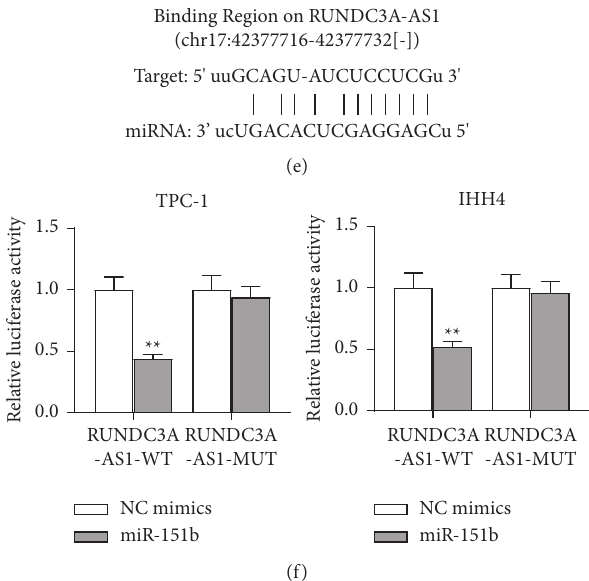
Figure 3: RUNDC3A-AS1 binds to miR-151b. (a) ENCORI showed two miRNAs that have binding sites with RUNDC3A-AS1 (CLIP data ≥ 1, Pan-cancer ≥ 10). (b) ENCORI showed the low expression of miR-151b in THCA. (c) The relative expression level of miR-151b in THCA cell lines was examined by RT-qPCR. (d) Overexpression efficiency of miR-151b was examined by RT-qPCR. (e) TargetScan predicted the binding sites between RUNDC3A-AS1 and miR-151b. (f) Luciferase reporter gene assay showed that miR-151b decreased the luciferase activity in the RUNDC3A-AS1-WT group. ∗∗ P < 0 . 01; ∗∗∗ P < 0 . 001.